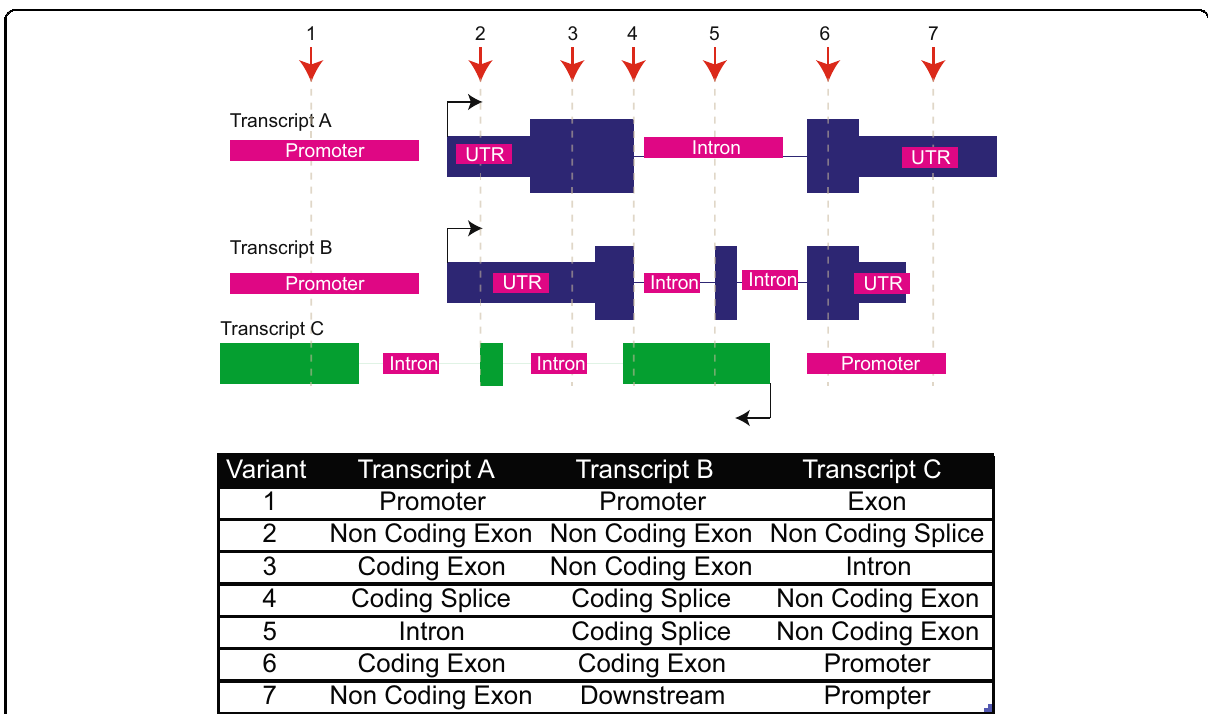
Fig. 3 The challenge of assigning variant impact in a complex genome. Assigning variants (red arrows) at a hypothetical locus where protein- coding transcripts (blue), lncRNA (green), and regulatory regions (magenta) are